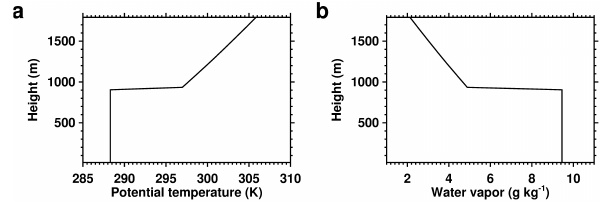
Fig. 1. Initial potential temperature and total water (as water vapor) profiles. In the boundary layer, potential temperature is initialized with 288.3K, and total water with 9.45gkg − 1